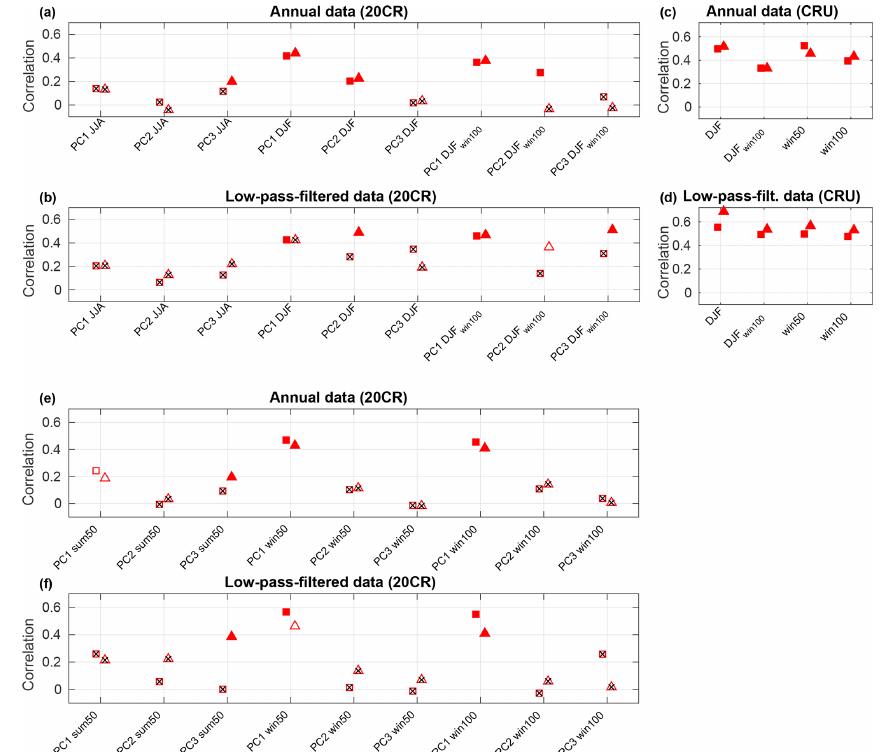
Figure 8. (a, b, e, f) Correlation analysis for reconstructed PC1, PC2 and PC3 of SLP using eight ice cores (triangles) and 19 ice cores (squares) correlated with PC1, PC2 and PC3 of 20CR SLP covering 1851–1970; (c, d) correlation analysis for reconstructed PC1 SLP using eight ice cores (triangles) and 19 ice cores (squares) correlated with station-based NAO covering 1824–1970. The station-based NAO is only valid for winter and annual data due to the seasonal shift in the centers of action. Open markers indicate significance of p < 0 . 1, and full markers indicate p < 0 . 05, while crossed-out markers indicate p > 0 .